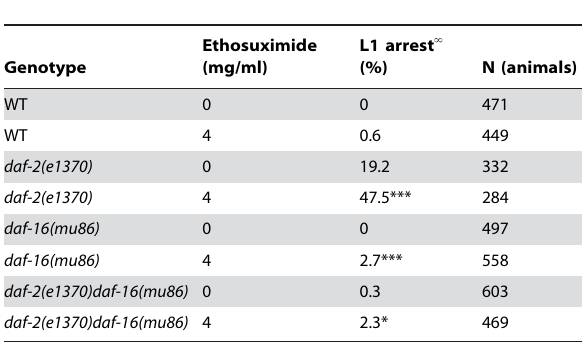
Table 5. Ethosuximide enhanced daf-2(e1370) L1 arrest.